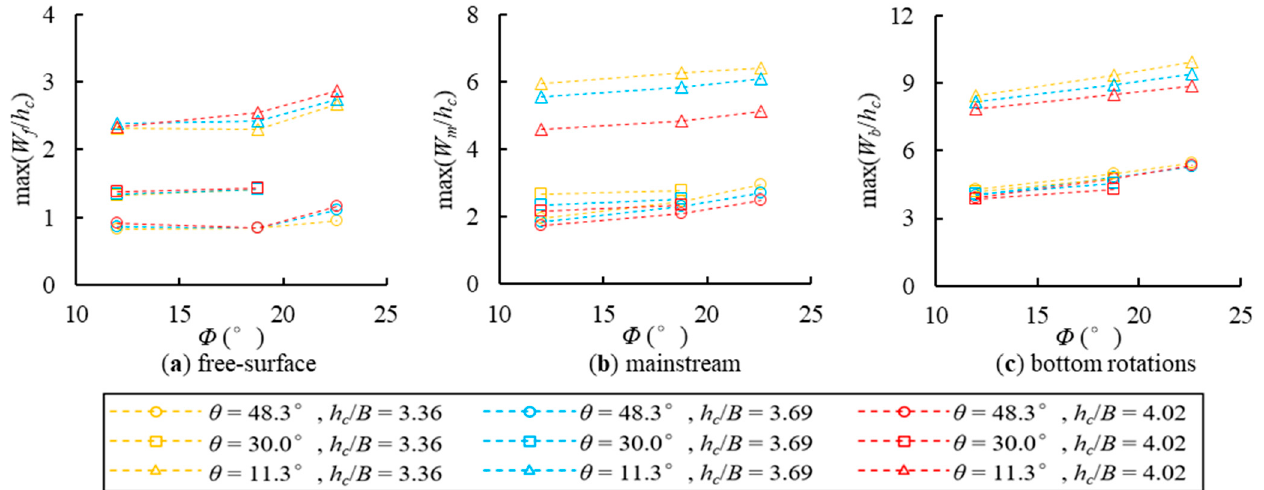
Figure 10. Maximum disturbed region widths of max( W f / h c ), max( W m / h c ) and max( W b / h c ) for ( a ) free-surface; ( b ) mainstream; and ( c ) bottom rotations.